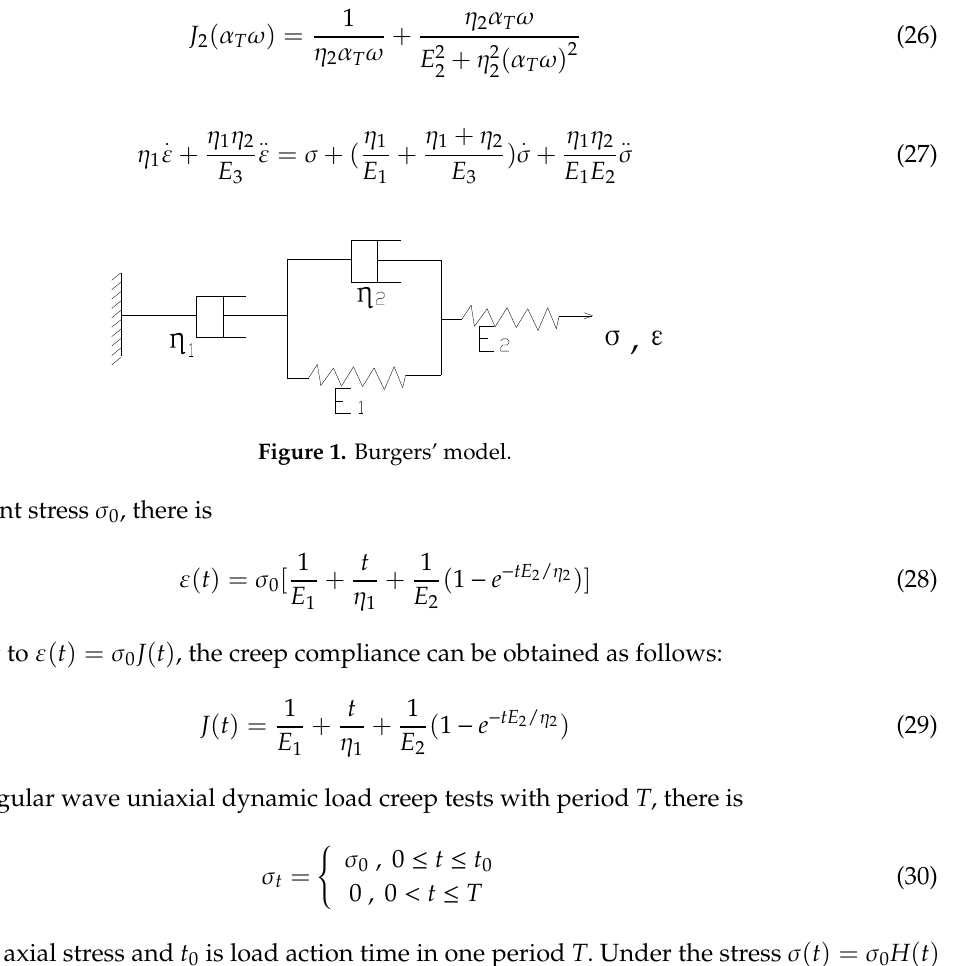
Figure 2. Boltzmann's superposition principles.